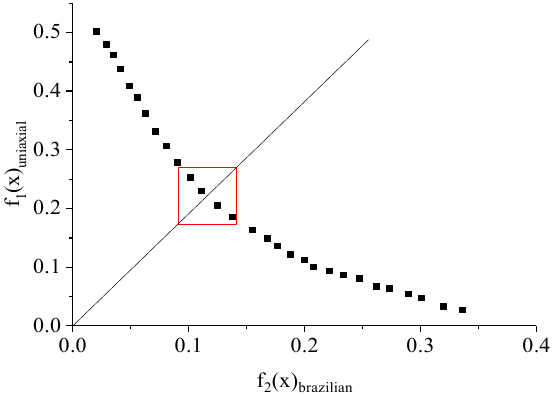
Figure 11. Obtained Pareto optimal points by the present method. Table 5. Initial identification results.